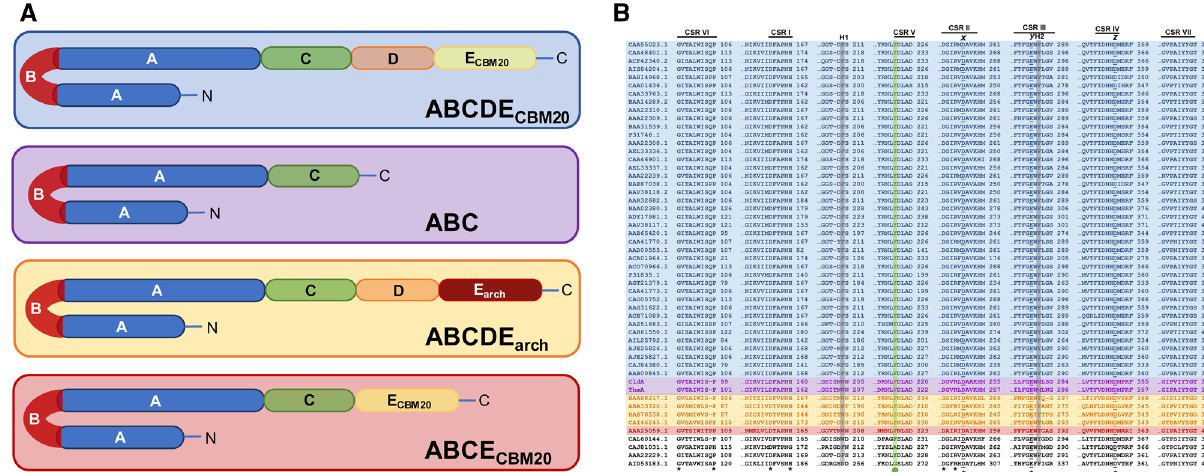
Figure 1. CGTases with different domain organizations. ( A ) Schematic representation of conventional five- domain ABCDE CBM20 CGTases (blue), five-domain ABCDE arch CGTases (orange), and four-domain ABCE CBM20 CGTases (red), which are recognized by CAZy. Note that the novel group of 19 CGTases, (CldA/ThmA)- like enzymes from thermophilic C. subterraneus ssp. and Thermoanaerobacter spp., showed a three-domain ABC architecture (magenta). ( B ) Multiple amino acid sequence alignment of CGTases from GH13_2 with a conventional five-domain ABCDE CBM20 (blue), five-domain ABCDE arch (orange), four-domain ABCE CBM20 (red), and three-domain ABC distribution (magenta), as well as maltogenic starch-acting enzymes (white). Note the CSR I-VII motifs showing functionally critical residues (asterisk) for the GH13 family. The underline indicates the conserved acidic catalytic triad Asp x , Glu y , and Asp z from CSR II, III, and IV, respectively. The conserved aromatic central Tyr/Phe residue (green sphere) and the hydrophobic pair (Phe/Trp/Tyr)/(Phe/Tyr/Met) (H1 and H2 shadow boxes), which are essential for the cyclization activity of CGTases and to distinguish them from α-amylases are also showed 13,30,31 . The same color code is used in all other